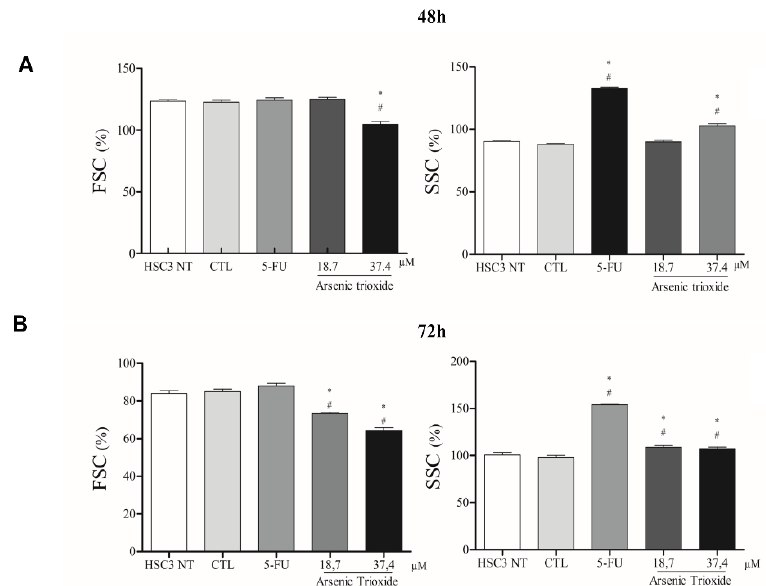
Figure 5. The graphical representation of light scattering characteristics of HSC3 cells, as determined by flow cytometry after 48 h ( A ) and 72 h ( B ) of treatment. The percentage (%) of FSC (Forward Scatter) and SSC (Side Scatter) correspond to mean ± SEM of three independent experiments carried out in duplicate. (*) p ≤ 0.05 compared to the negative control (CTL), and (#) when compared to the HSC3 NT group (non-treated cells) by ANOVA (analysis of variance) followed by Student Newman-Keuls test.